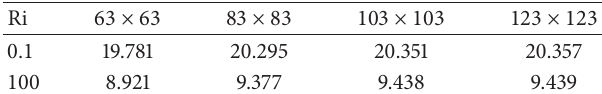
Table 2: Effect of the grid size on Nu the Cu-water nanofluid (𝜑 = 0.05) having a pair of triangular heat sources with size 𝑊 = 𝑤/𝐻 = 0.2 for case 1 (see Figure 1).